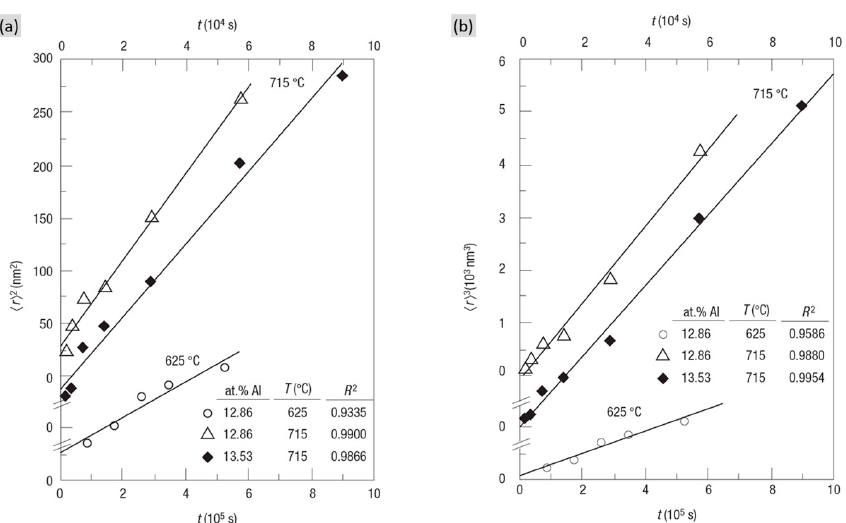
Figure 4. The plots showing the average γ ’ precipitate size raised in ( a ) square rate law and ( b ) cubic rate law versus thermal exposure time in a Ni-Al binary alloy [42]. rate law versus thermal exposure time in a Ni-Al binary alloy